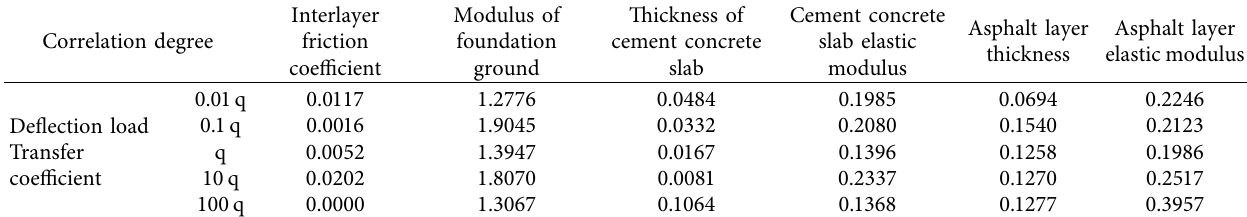
Table 5: Sensitivity analysis.